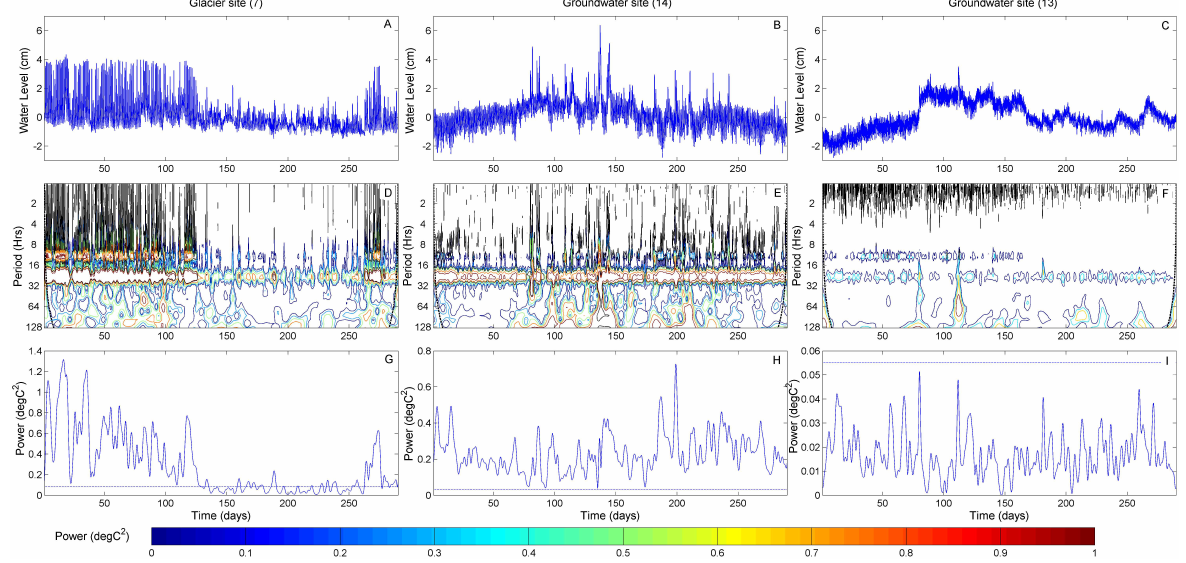
Fig. 6. Wavelet analysis outputs at three stream sites (7, 13, 14) with contrasting glacial influence (site 7 is glacier-fed while site 13 and 14 have no superficial connection to the glacier – but site 14 has glacial resurgence as indicated by significant diurnal flow variation). (A) , (B) , (C) : averaged normalized water-level time series. (D) , (E) , (F) : local wavelet power spectrum normalized by their standard deviations. The black line delineates the areas where the power is considered significant (i.e., exceeds the 95% confidence level of a red-noise process); the dashed black line delineates the cone of influence that delimits the region not influenced by edge effects. (G) , (H) , (I) : normalized scale- averaged wavelet power spectra at 24h. The dashed blue line shows the corresponding 95% confidence level for the red-noise spectrum. In each panel, day one corresponds to the 1 January 2010. The color bar shows the legend for the different colors: blue and red for low and high wavelet power,